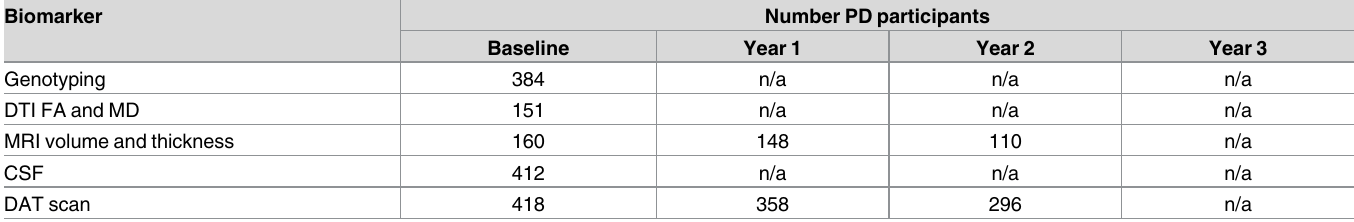
Table 2. Biomarker availability at baseline and